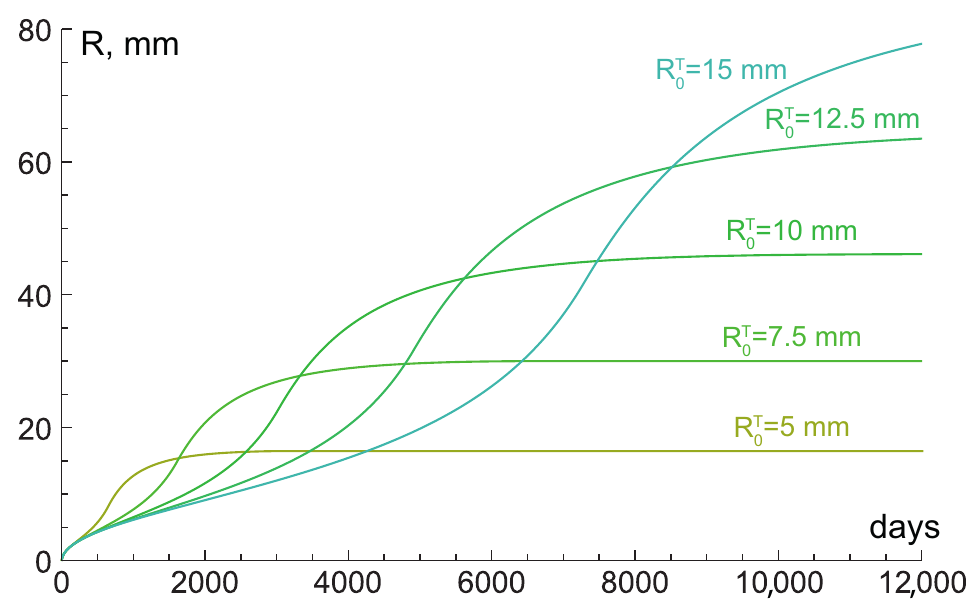
Figure 13. Tumor growth curves, produced by numerical simulations of the system of Equation (6) under nutrient supply level P = 4, tissue hydraulic conductivity K / µ = 0.003 and different values of initial radius of region of normal tissue, that surrounds tumor, R T 0